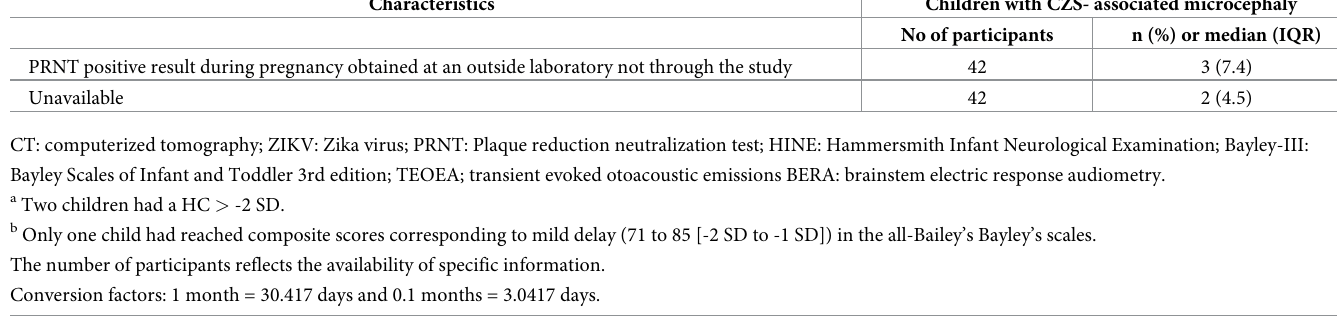
(Table 1 and Fig 1). When we compared HC at birth [Z score of -3.8(IQR -4.5 –-2.7)] with HC at the follow-up [Z score of -6.4(IQR -7.4 –-3.9)], we found a significant decrease (p < 0.001) in HC (Fig 1). All children had cerebral palsy, bilateral spasticity that compromised their movement, poor head control and hyperreflexia. This required all children to be transported in a manual wheel- chair in all settings. All children were categorized by a neuropediatrician as Level V according to the Gross Motor Function Classification System. Among 35/42 (83.3%) children with HINE results, median age was 27.8 months (IQR 25.1–31.6). All children had low scores in the HINE neurological section and significant delays in achievement of motor milestones. The median HINE neurological section score was 25.0 (20.5–33.0) and median motor score was 2.0 (IQR 1.0–4.0). The mean score for the HINE behavioral section was much better at 13.0 (IQR 11.3– 15.0) (Table 1 and Fig 2). (IQR 29.4–37.5). In our evaluation of child development using Bayley scales, 32/33 (97.0%) in all Bayley-III scale evaluated (Table 1). Composite and raw scores did not show any trend when compared with the age at follow up (Fig 3).